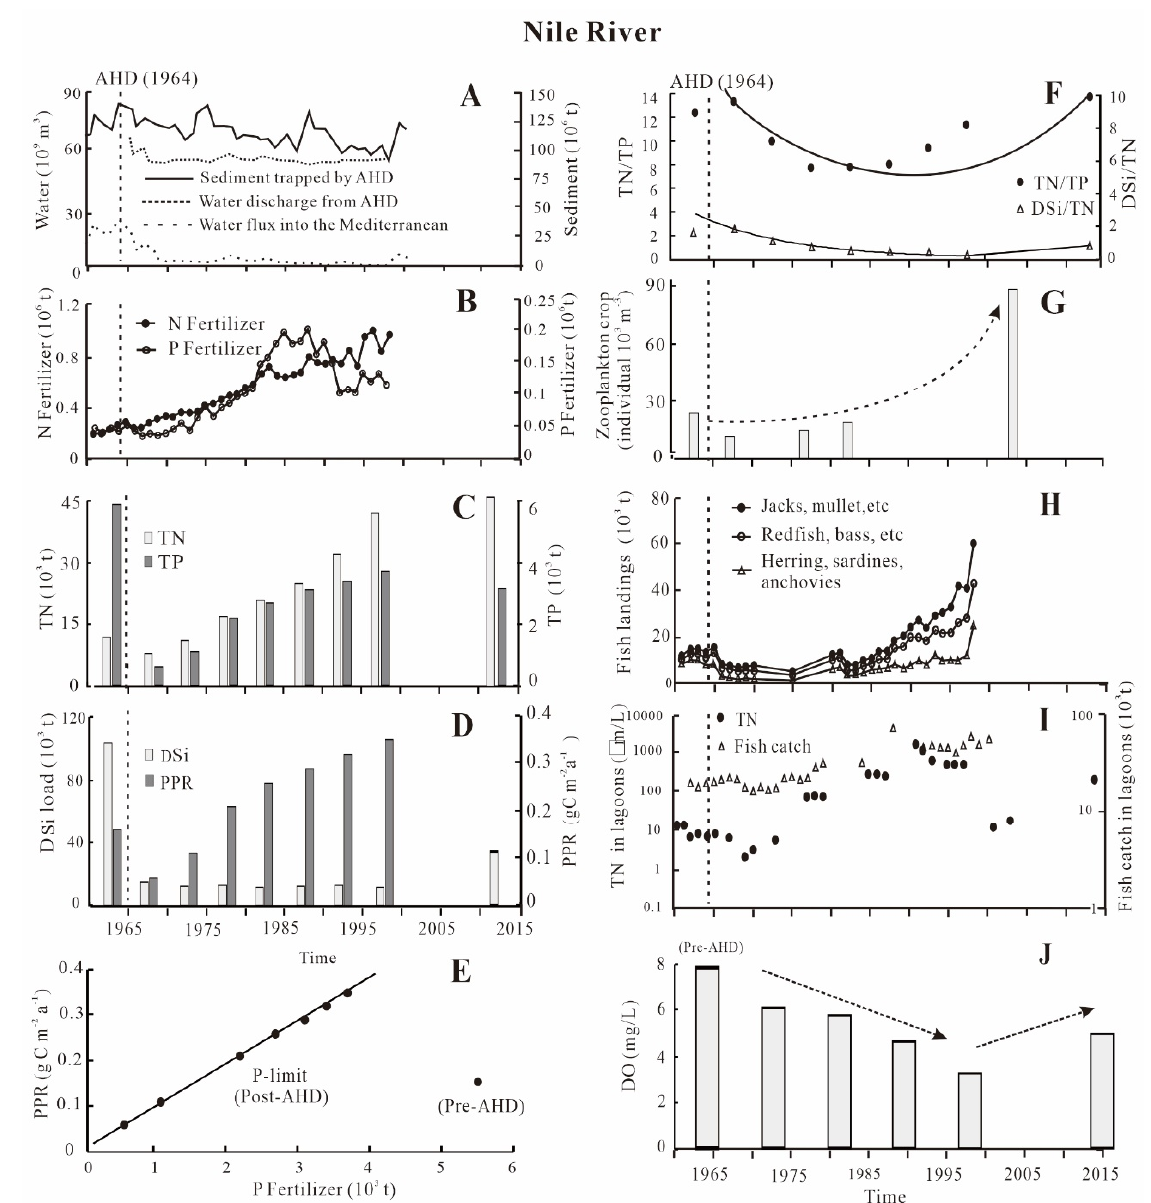
Figure 3. Long–term variations of both Nile River riverine materials transport to the delta-estuary and estuarine ecological components. ( A ) Sediment and freshwater [12]; ( B ) Fertilizer [13]; ( C ) TN and TP loads [14,15]; ( D ) DSi load and PPR [14,15]; ( E ) PPR and P-fertilizer [13,14]; ( F ) N/P and DSi/TN [14,15]; ( G ) Zooplankton crop in Abu-Qir Bay [16]; ( H ) Fish landing [13]; ( I ) Inorganic nitrogen concentrations and the fish catch of the 4 Nile lagoons [17,18]; ( J ) Dissolved oxygen (DO) concentrations in the Maryut Lagoon [18,19];. TN: total nitrogen; TP: total phosphorus; PPR: primary production rate.